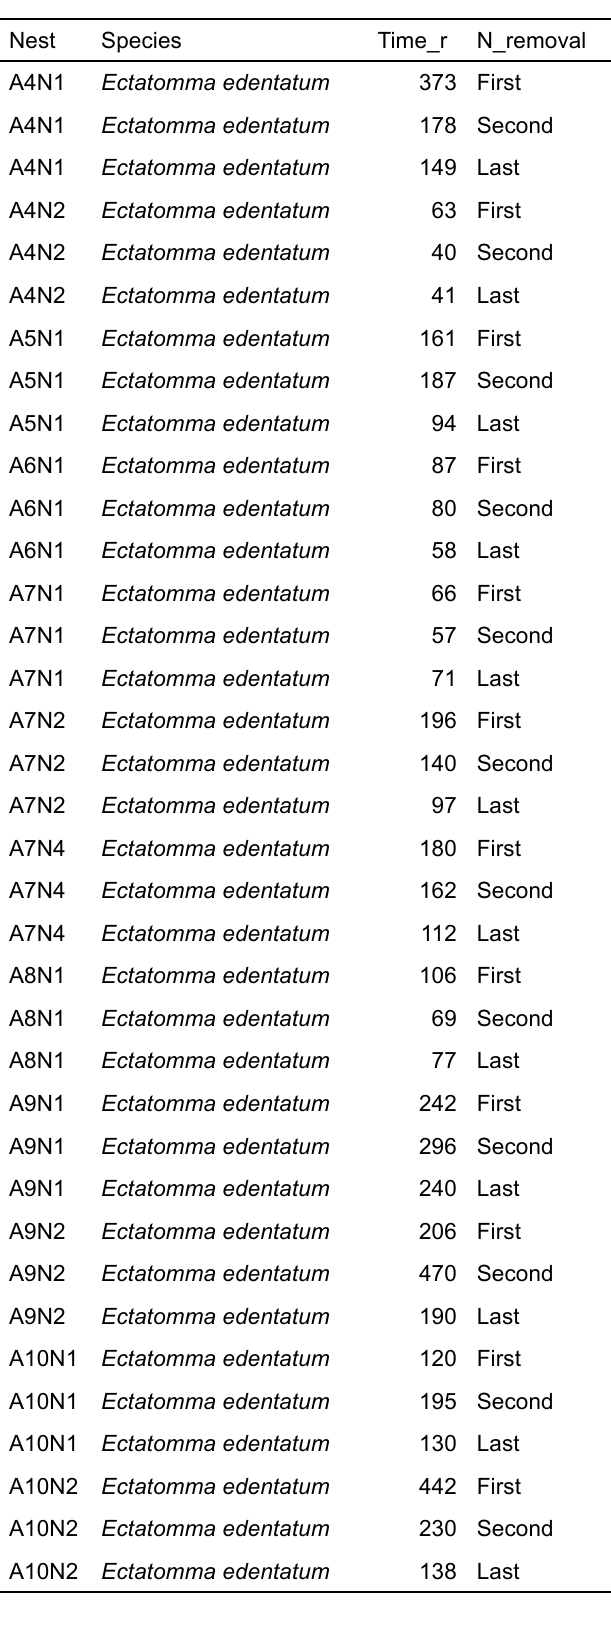
Table S2 . Nests sampled in each area, species sampled (only Ectatomma edentatum ), removal performed (first, second, and last), and removal time